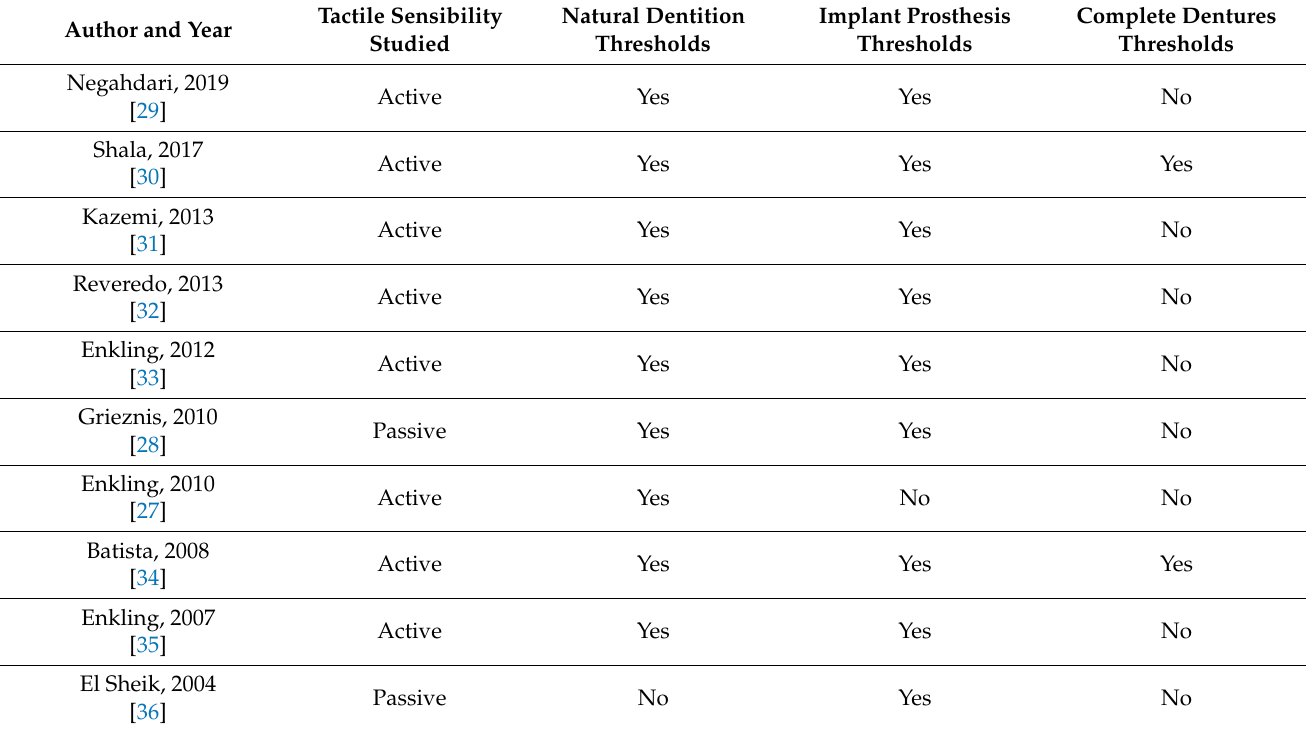
Table 1. Showing which kind of sensibility and prosthesis was involved in each investigation.